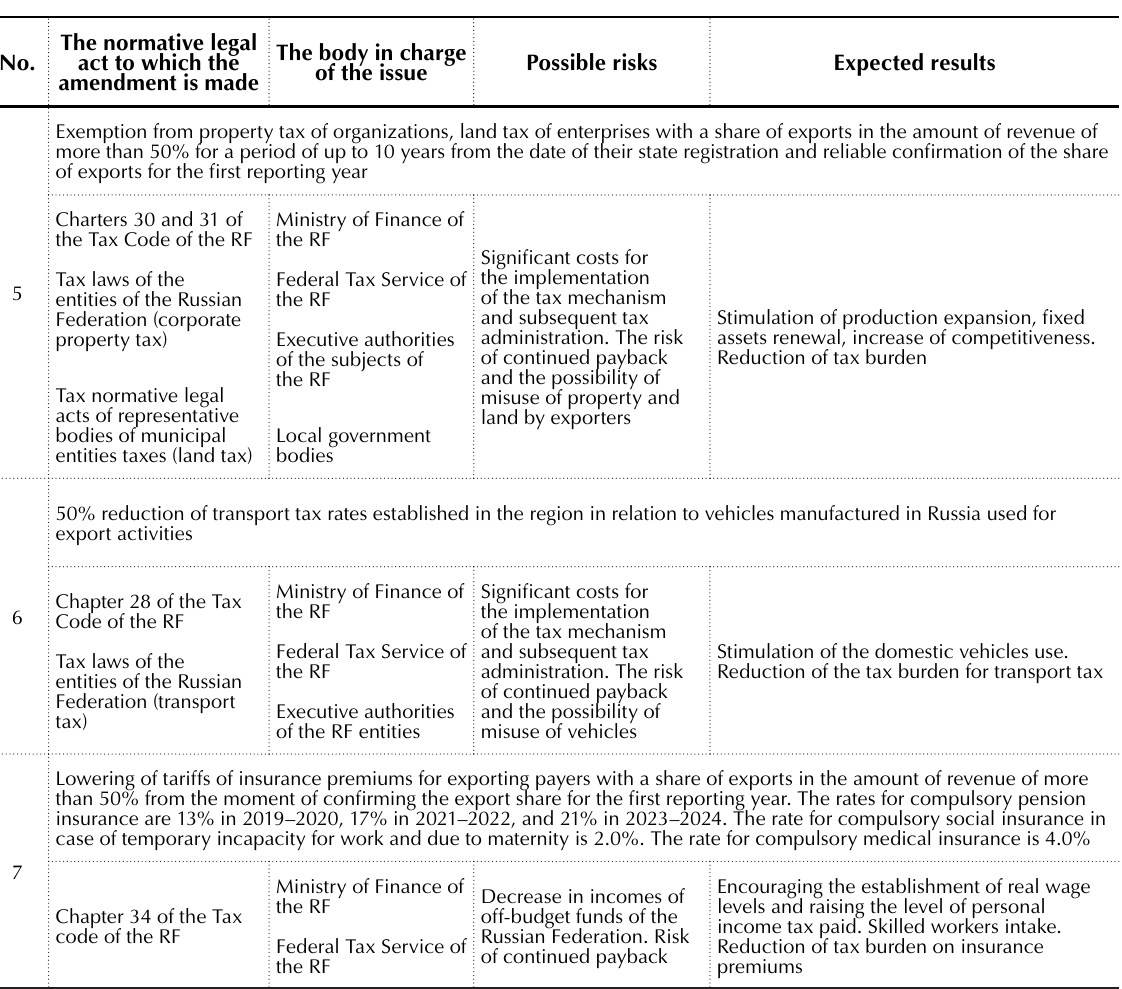
Table 2 (cont.). Proposed measures of tax incentives for non-primary export in